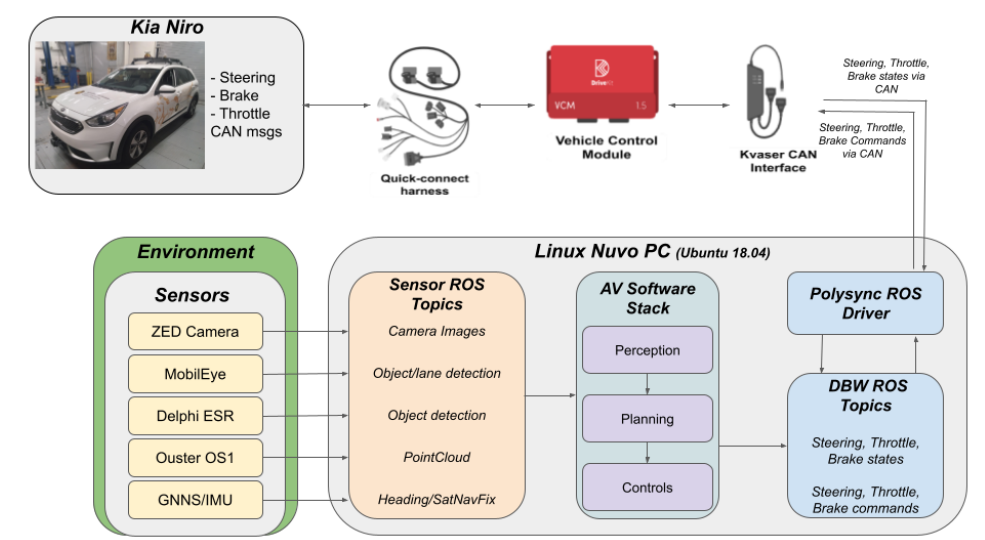
Figure 11. Sensor system diagram for the Ego vehicle Kia Niro platform. The flowchart shows the interaction with the vehicle, integrated sensors, Drive-Kit, the autonomous stack, and the flow of information between them